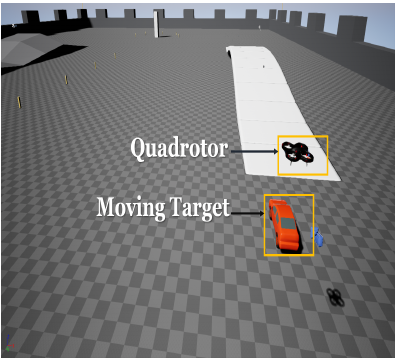
Figure 4. A snapshot of simulation setup consisting of airsim flying quadrotor vehicle and a ground vehicle as landing target.